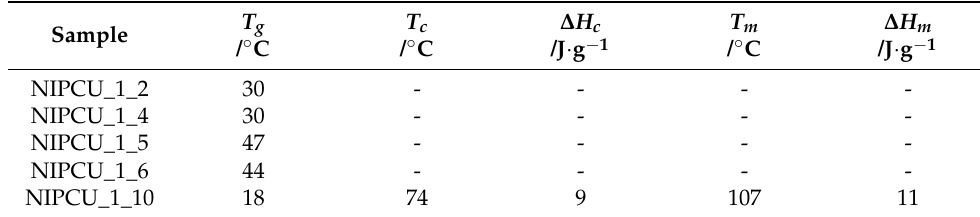
Table 2. Thermal properties of the obtained